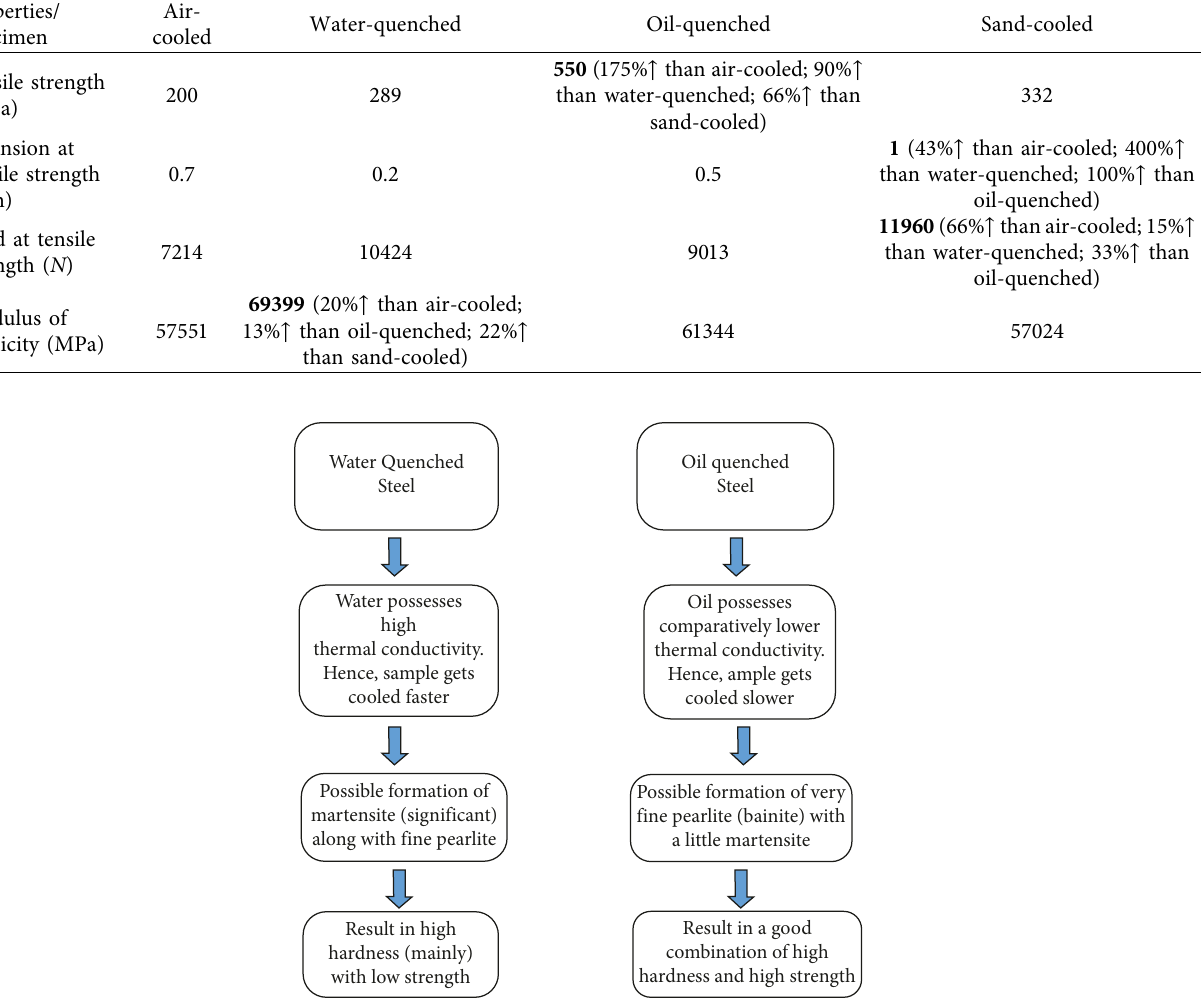
Figure 4: Comparative assessment between water-quenched and oil-quenched